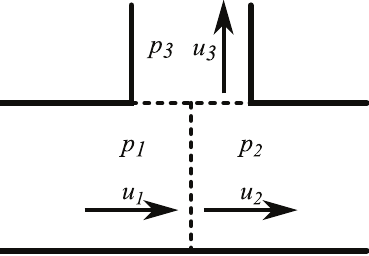
l = 1.708 e (cid:3) 5 (1 + 2.9 e (cid:3) 3 Figure 3. Sketch of a T-junction with the adopted convention for the fl ow orientation.